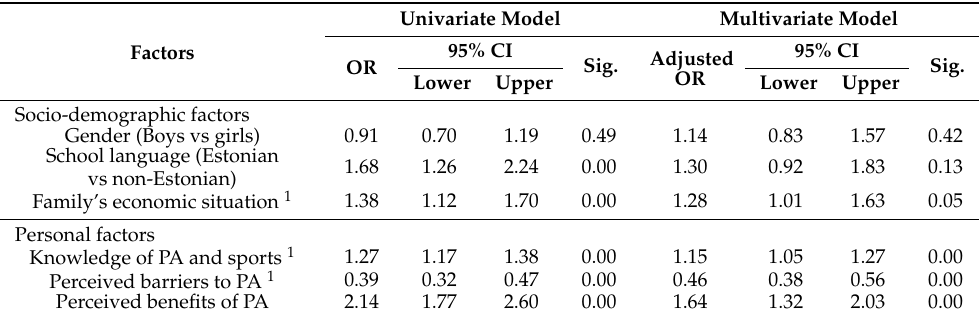
Table 5. Logistic regression analysis of the socio-demographic and personal factors associated with participation in organised sports training. Univariate Model Multivariate Model 95% CI Factors Sig. Adjusted OR OR Socio-demographic factors Gender (Boys vs girls)